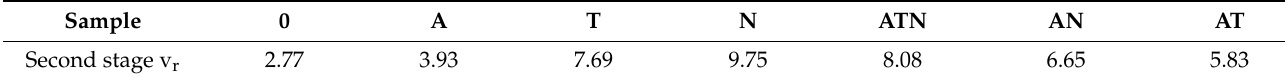
Table 2. Dissolution rate of lime (10 –5 cm/s).